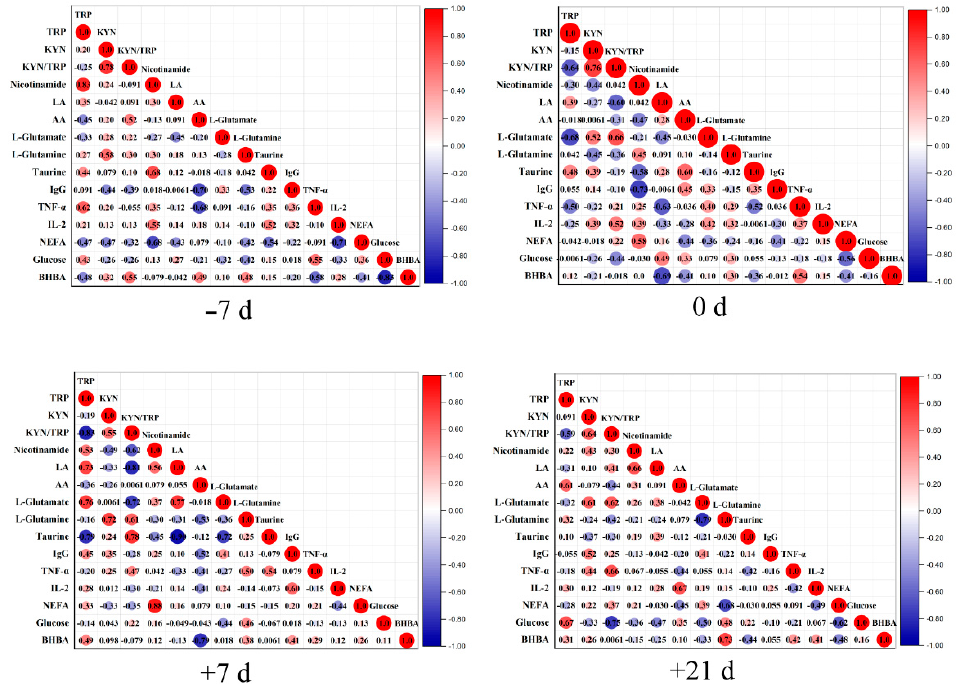
Figure 9. Spearman correlation heat maps for correlations between phenotypic variables (NEFAs, BHBA, IgG, IL-2, and TNF- α ) and key differential metabolites on − 7, 0, +7, and +21 d relative to calving. The scale indicates the level of correlations. KYN—kynurenine; TRP—tryptophan; LA— linoleic acid; AA—arachidonic acid; KYN/TRP—kynurenine-to-tryptophan ratio.